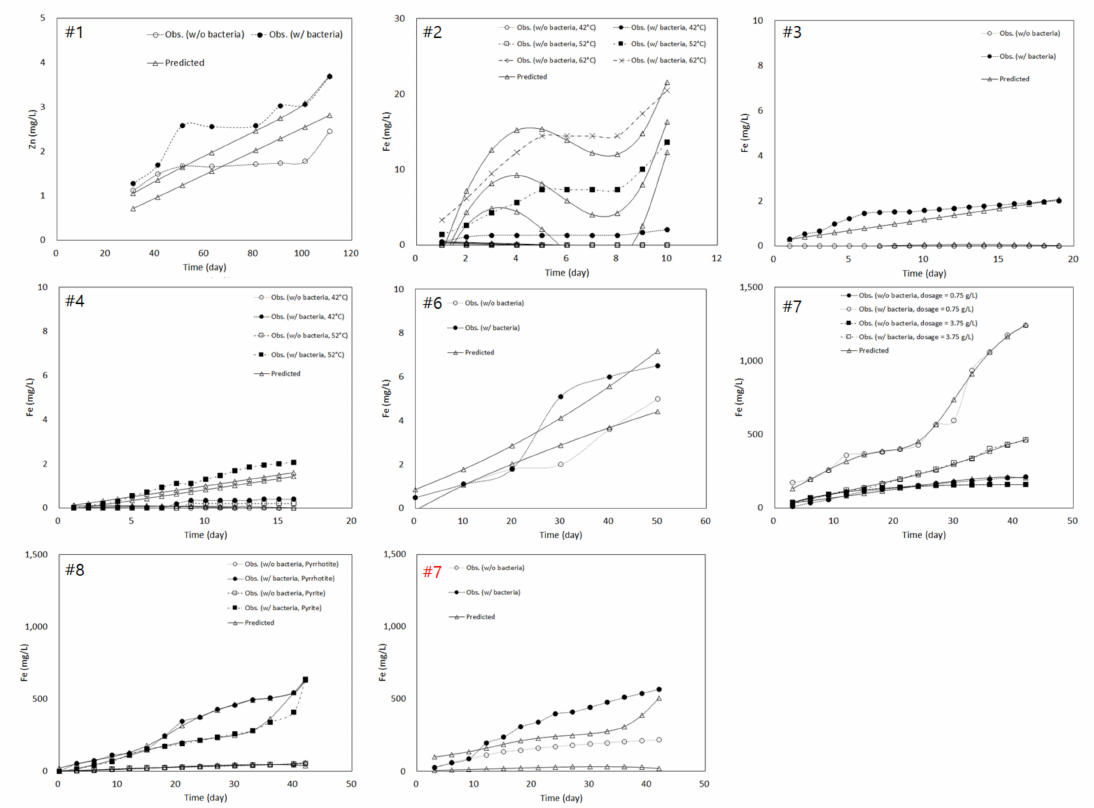
Figure 8. Observed and ANN-predicted Fe concentration changes with a topology of 9:11:1. The numbers are from Table 1, while the red number is the result from the data for further